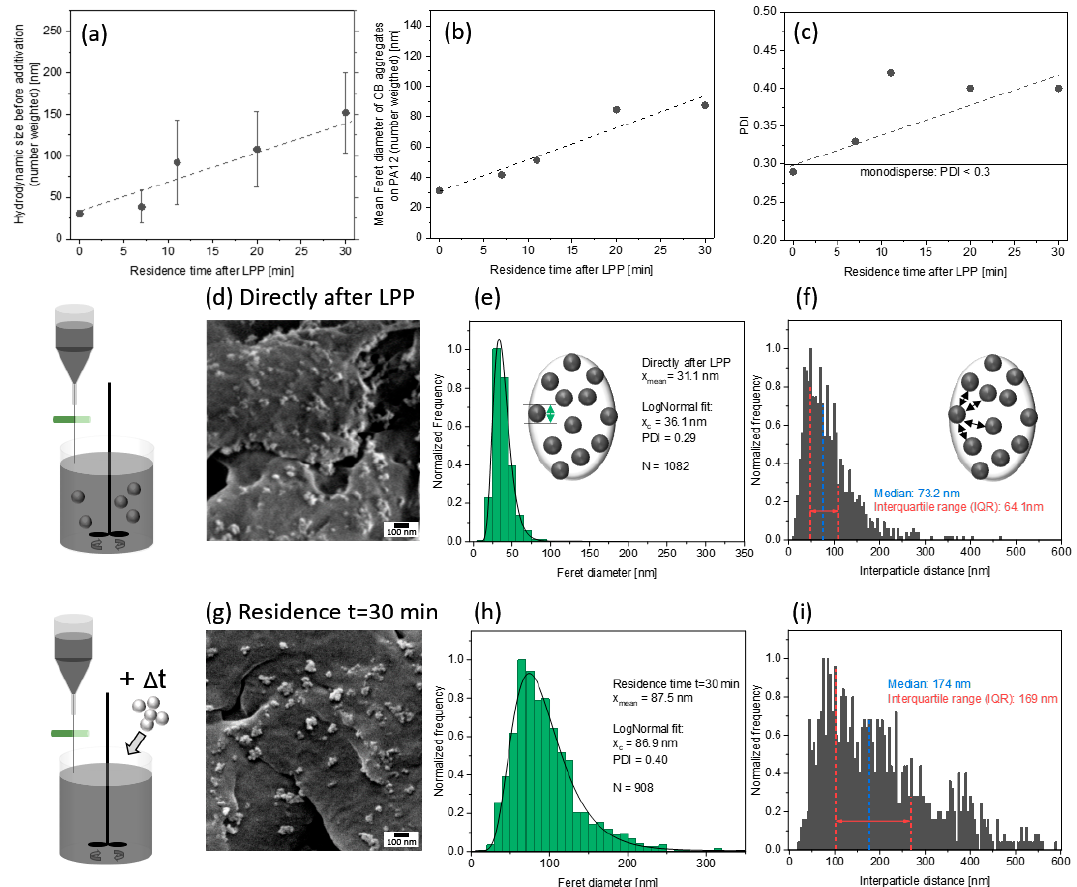
Figure 7. Comparison of ( a ) the hydrodynamic diameter after LPP with ( b ) the achieved Feret max diameters (primary particle diameter) of carbon nanoparticles on the polymer particle surface; ( c ) the corresponding polydispersity index (PDI) of carbon nanoparticles on the polymer particle surface at 0.005 vol%. SEM image of the PA12 particle surfaces after ( d , g ) colloidal additivation. ( e , h ) Corresponding number-weighted Feret max size distribution of carbon nanoparticles on the surface of PA12 particles and ( f , i ) interparticle distance distribution. For the comparison of particle size and interparticle distance, several images were taken for each sample at the same resolution. Nanoparticles and distances were analyzed for at ~1000 nanoparticles, e.g., N = 1082 in panel ( e ) and N = 908 in panel ( h ).